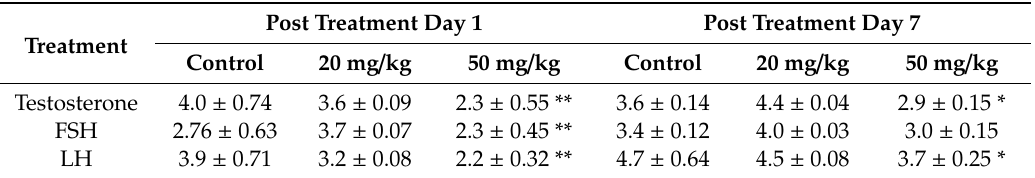
Table 4. Serum testosterone, follicular-stimulating hormone (FSH), and luteinizing hormone (LH) of male rats, treated either with 20 or 50 mg / kg of Judo or distilled water.